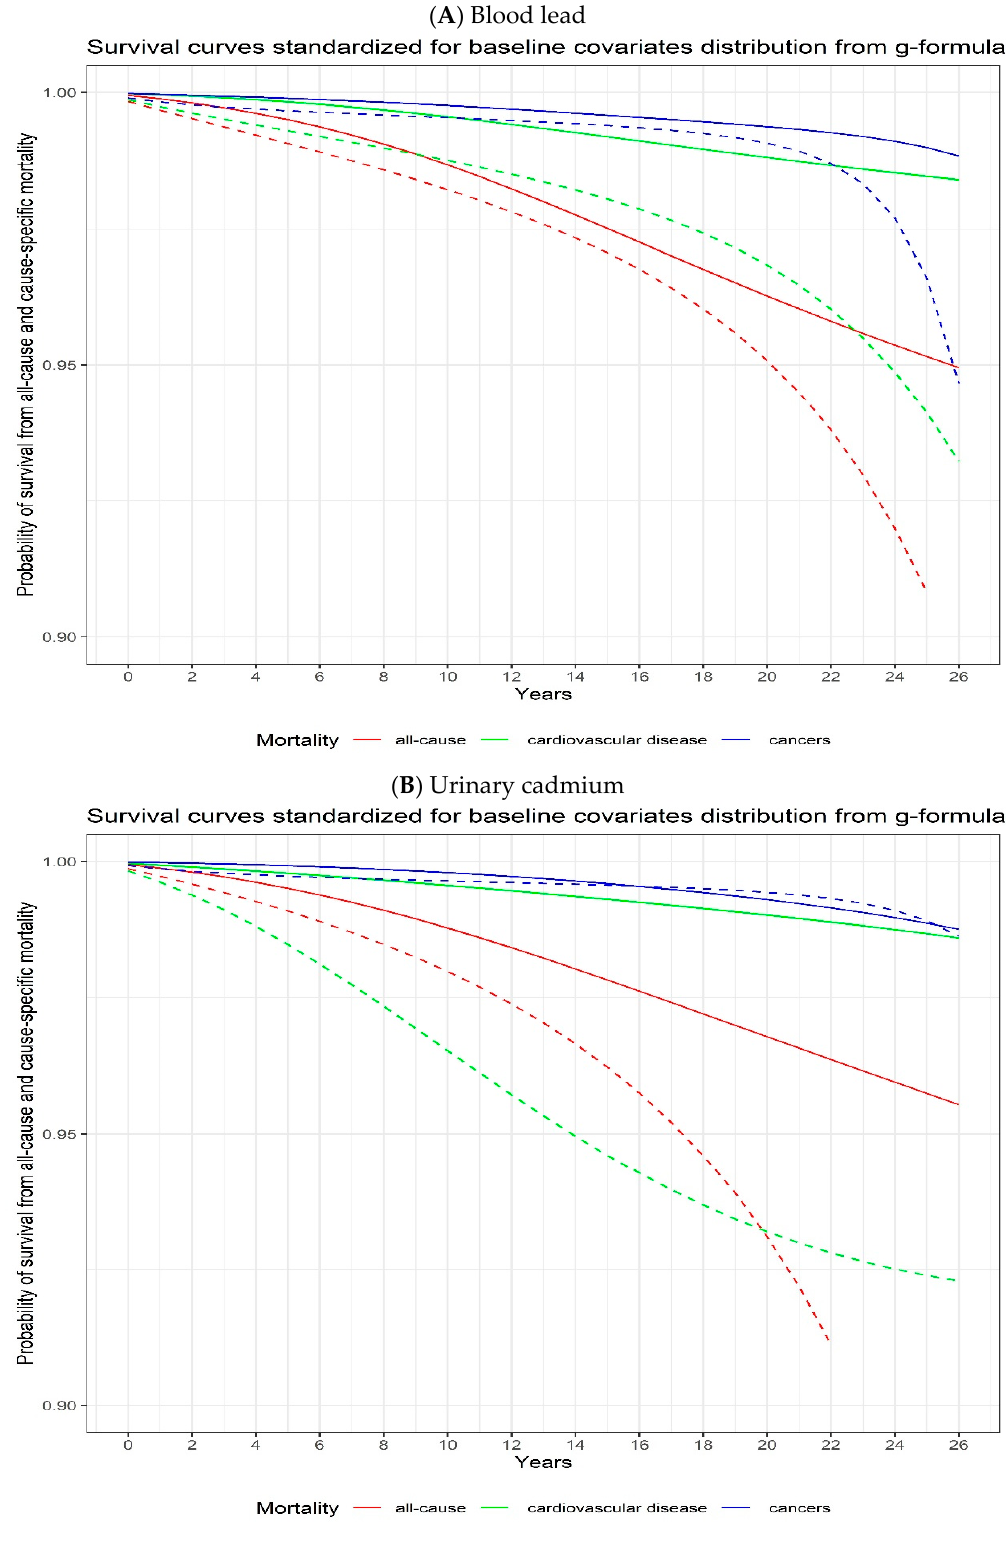
Figure 2. Adjusted all-cause, cardiovascular disease, and cancer mortality risks according to blood lead ( A ) and urinary cadmium ( B ) levels using parametric g-formula with pooled logistic regression models. The solid lines represent the first quartile and the dashed lines represent the fourth quartile. Robust 95% confidence intervals (CIs) for each exposure category estimated by bootstrapping (in the pooled logistic regression model) are presented in Table 3.